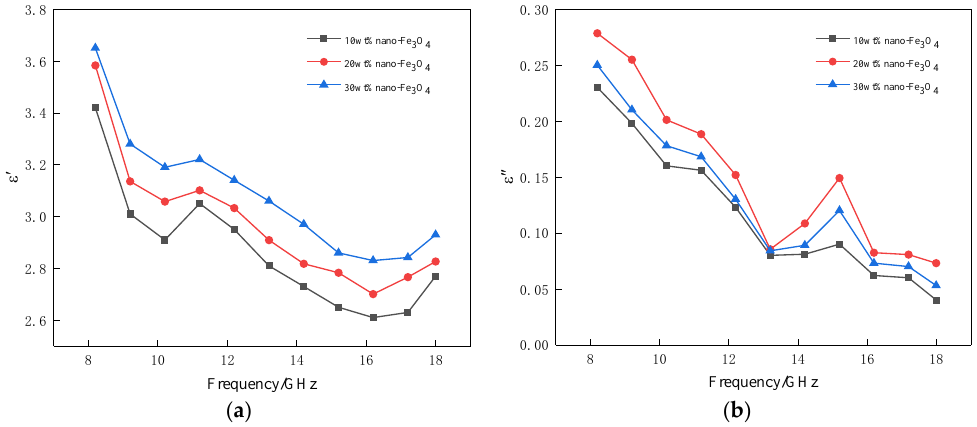
Figure 5. Complex permittivity of nano-Fe 3 O 4 / PLA composite absorbers with di ff erent nano-Fe 3 O 4 content. ( a ) The real part of the complex permittivity; ( b ) the imaginary part of the complex permittivity.